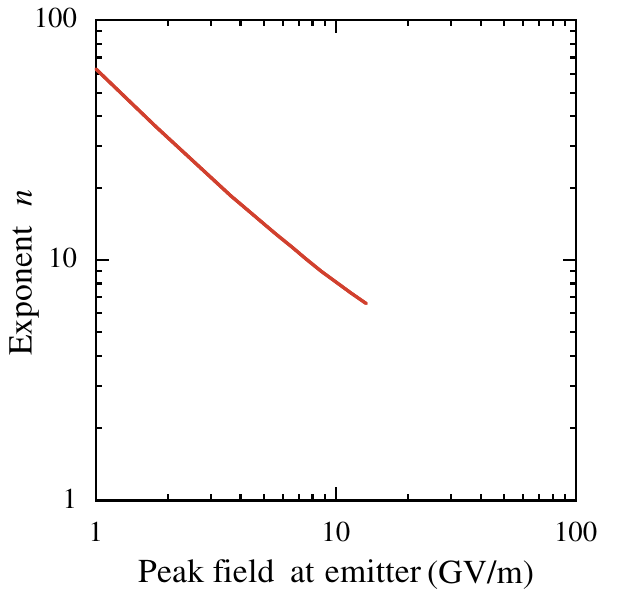
FIG. 34. (Color) Dependence of the rf correction factor, A the emitter field, from